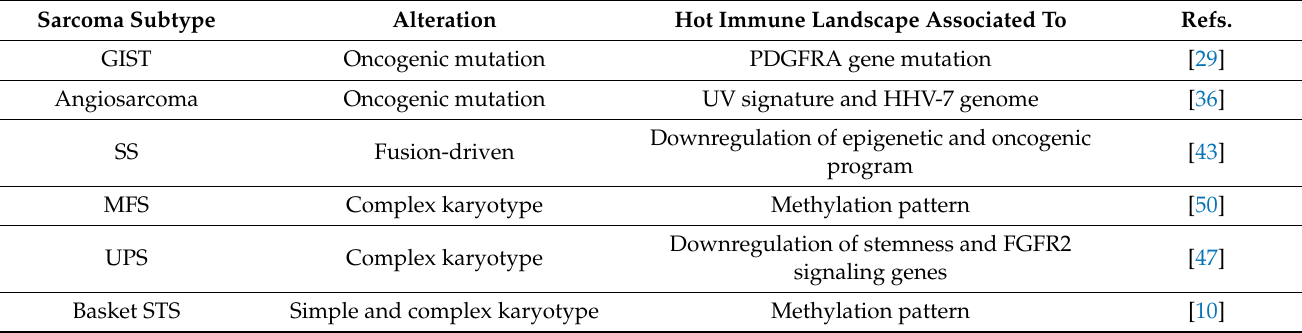
Table 1. Studies connecting genetic features and immunity in selected sarcoma histotypes. Sarcoma